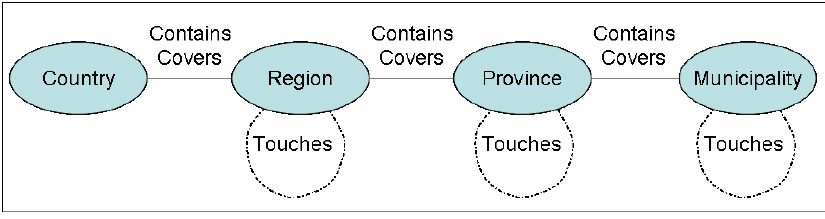
Figure 4. Example of administrative subdivisions with spatial